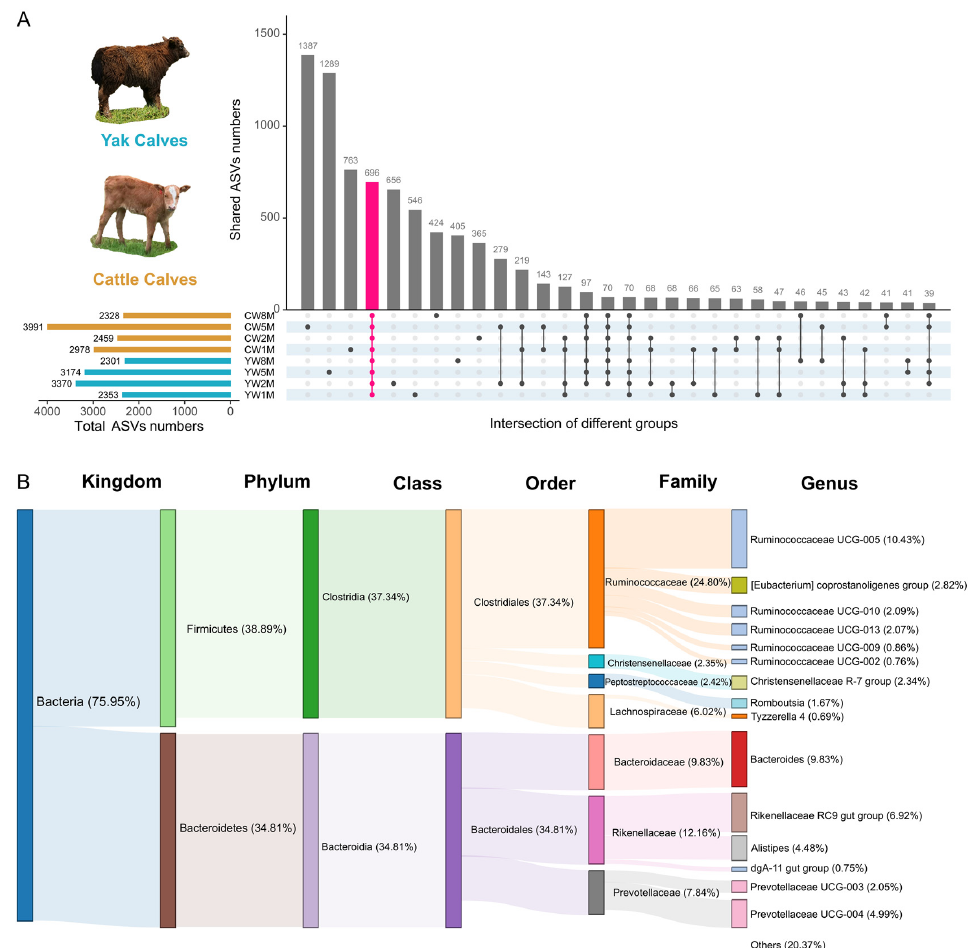
Figure 4. Analysis of the core fecal microbial community between yak and cattle calves in different months after weaning. ( A ) UpSet plots of common ASVs in fecal samples from yak and cattle calves in different months after weaning. The vertical bars or intersections represent the number of ASVs that were regulated by one or more samples type (intersecting conditions). The ASVs in each intersection were color-coded according to the meaning of their set. ( B ) Sankey diagram based on 696 shared ASVs at different taxonomic levels.